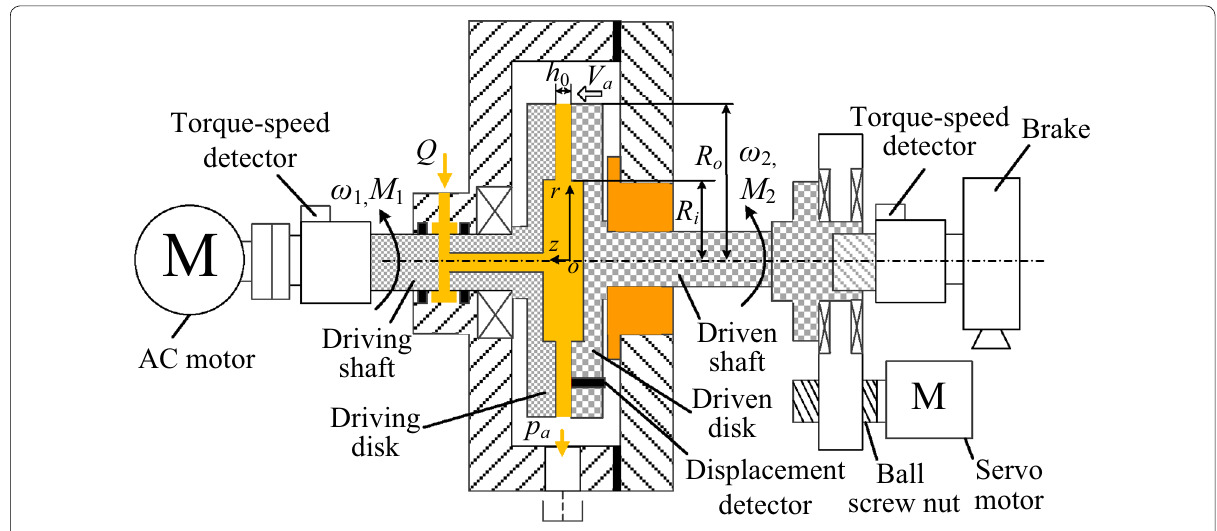
Figure 2 Sketch of the cutter-head driving system with the HVC